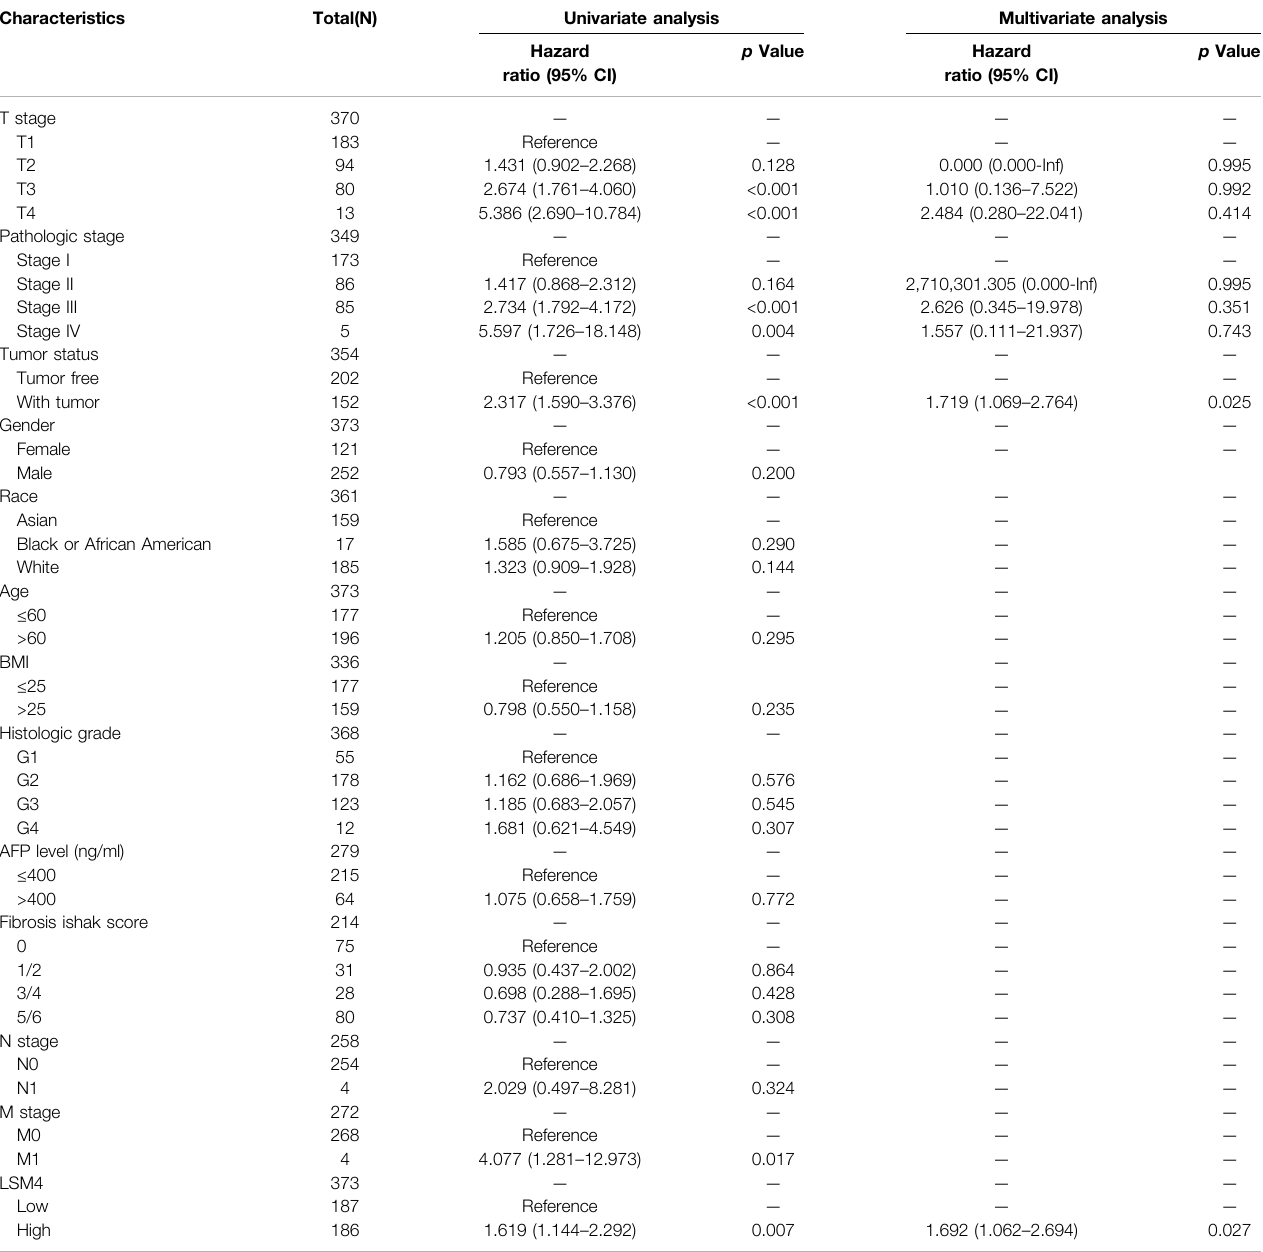
TABLE 2 | Univariate and multivariate cox analysis of hepatocellular carcinoma patients ’ overall survival.